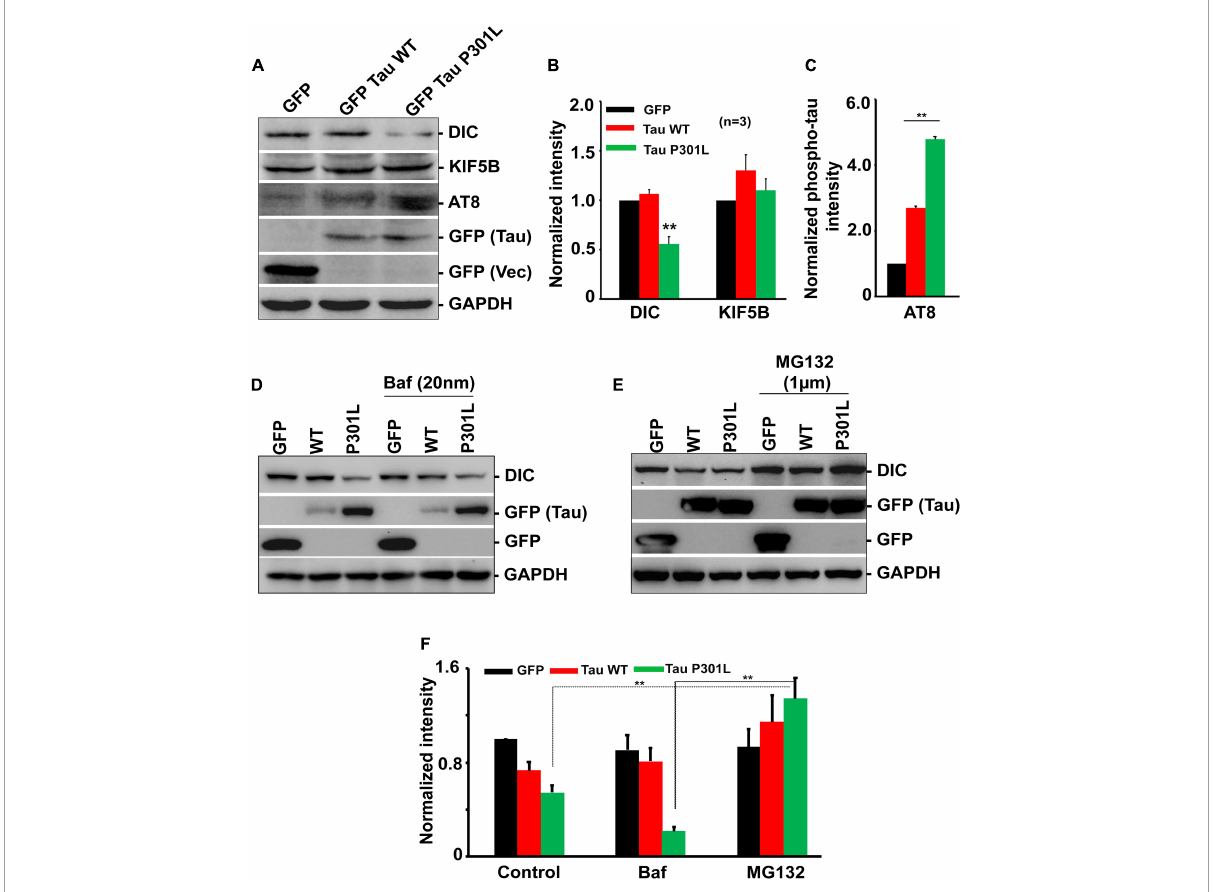
FIGURE3 Overexpression of P301L reduced cytoplasmic dynein but did not affect kinesin protein levels. (A) Representative immunoblot and (B,C) Quantitative analysis showing the expression of dynein (DIC) and kinesin (KIF5B) protein levels in cells expressing GFP, GFP Tau WT, and GFP Tau P301L. Levels of dynein are reduced in cells expressing P301L tau. Further cells were treated with (D) Bafilomycin (20 nM) to inhibit autophagy or (E) proteasomal inhibitor, MG132 (1 µ M), to examine the effect of two cellular degradation pathways on dynein protein turnover. MG132 restored dynein levels in GFP Tau P301L cells, indicating proteasomal-dependent degradation. (F) Quantitative analysis showing the expression of dynein during Bafilomycin (20 nM) and MG132 treatment. Data were obtained from three independent experiments, and error bars represent SEM. ** P < 0.01.